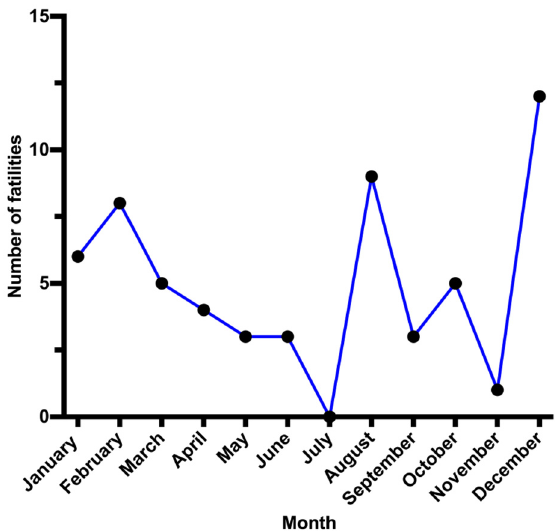
Figure 3. CO poisoning confirmed cases (n = 59) by month (2014–2018).